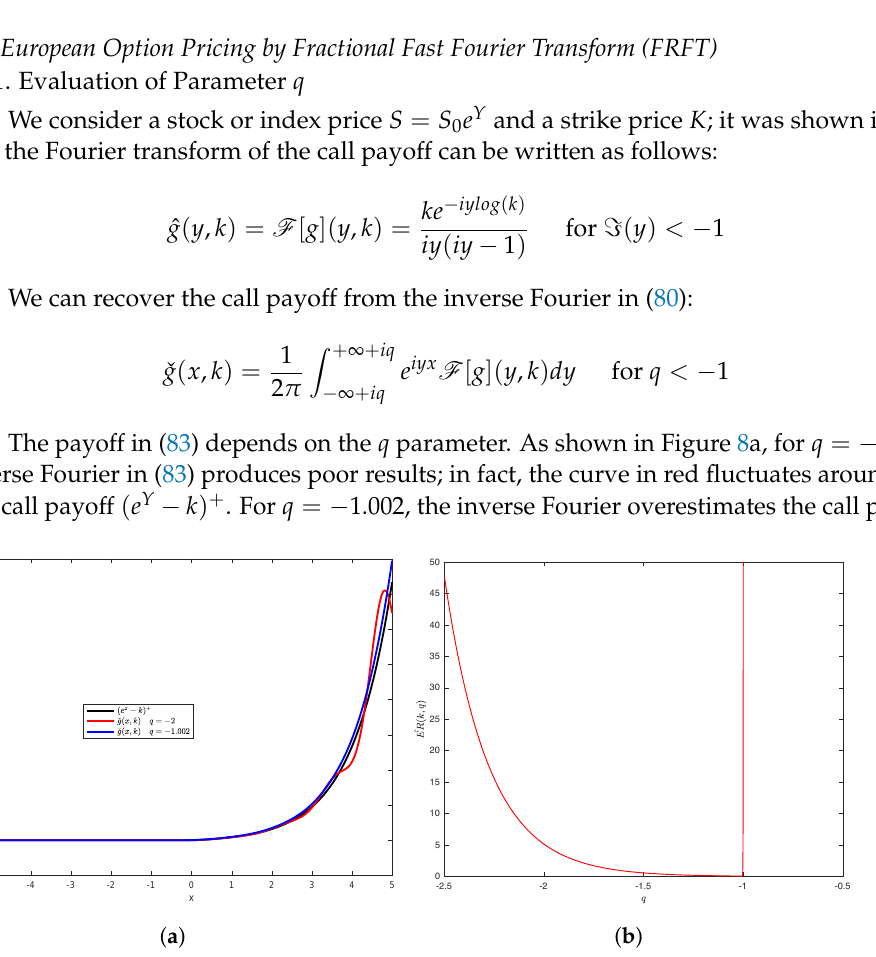
Figure 8. Optimal value of q parameter: ( a ) ( e x − k ) + versus ˇ g ( x , k ) ; ( b ) ER ( k , q ) and q